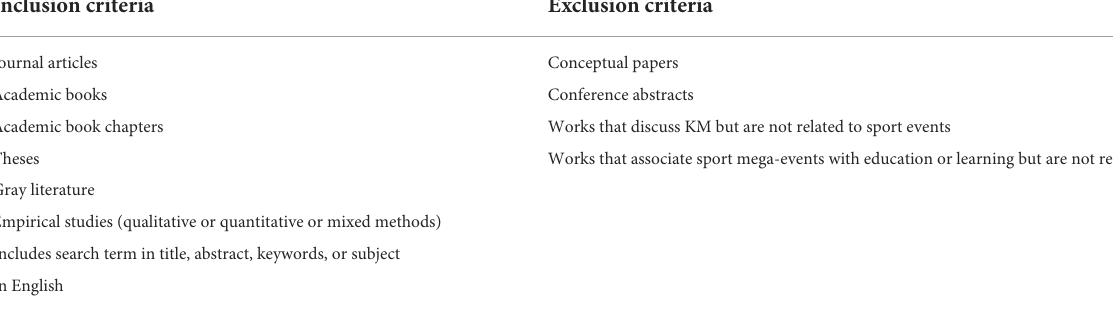
TABLE 1 Pre-selected inclusion and exclusion criteria for the systematic